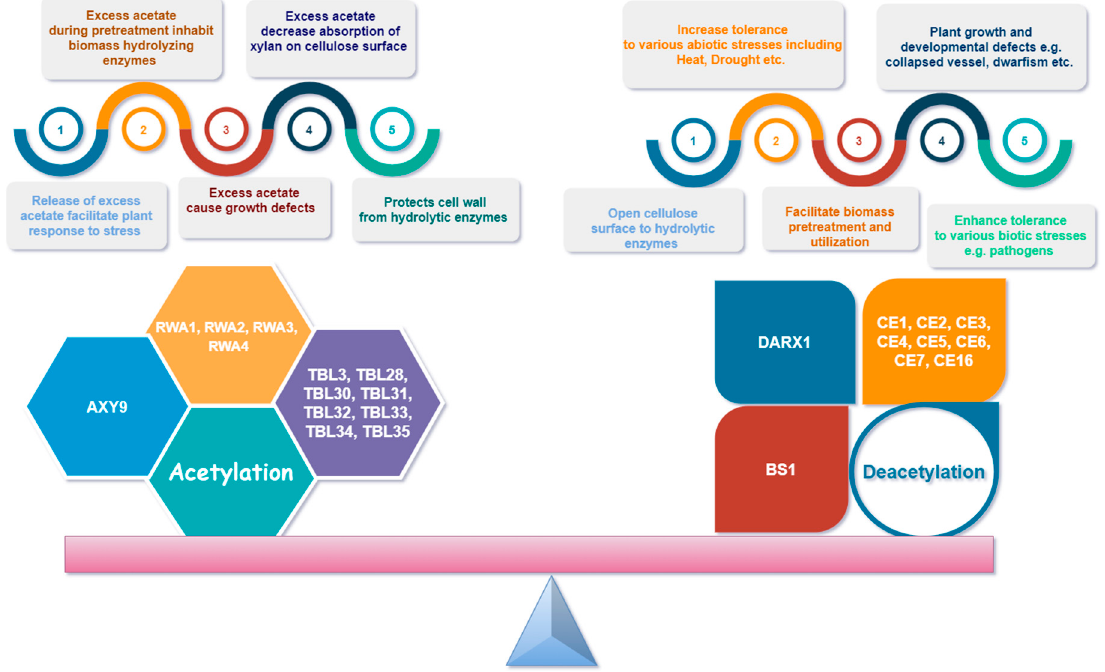
Figure 5. Importance of balanced xylan acetylation for plant development, environment tolerance, and polymer interactions.